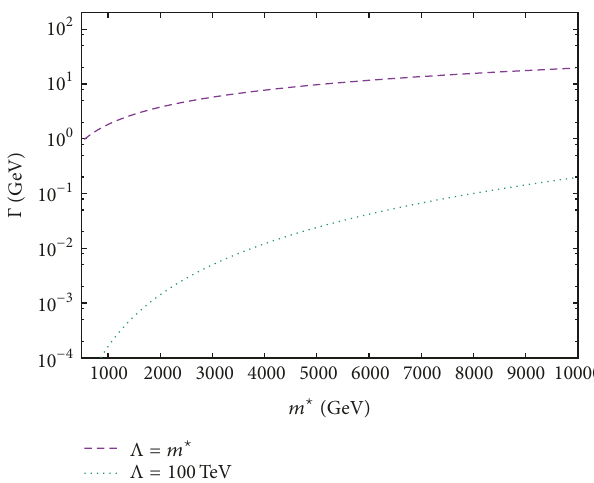
Figure 1: Decay width of excited leptons for Λ = 𝑚 ⋆ and Λ = 100 TeV.